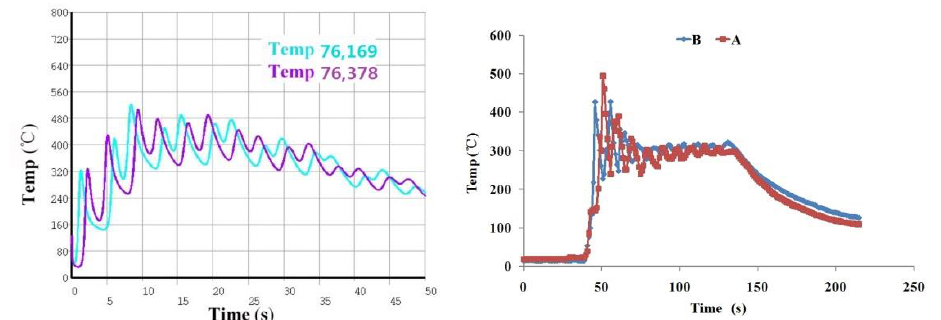
Figure 9. Simulation and experimental temperature comparison.